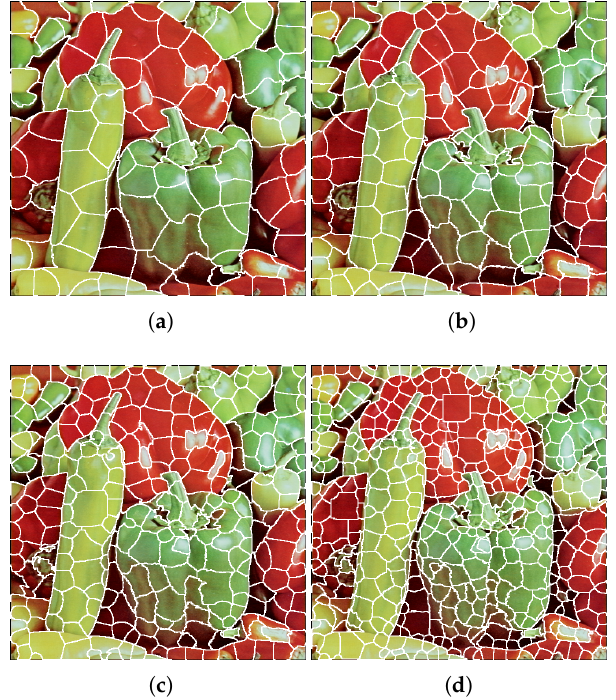
Figure 2. Superpixel decomposition for image Peppers with K = 32. ( a ) Image splitting into 96 su- perpixels ( N SP = 2). ( b ) Image splitting into 160 superpixels ( N SP = 4). ( c ) Image splitting into 288 superpixels ( N SP = 8). ( d ) Image splitting into 544 superpixels ( N SP =